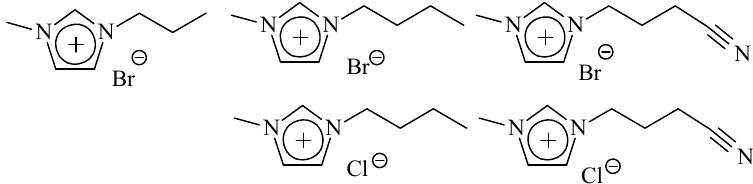
Figure 4. Structure of imidazolium salts used in [146].